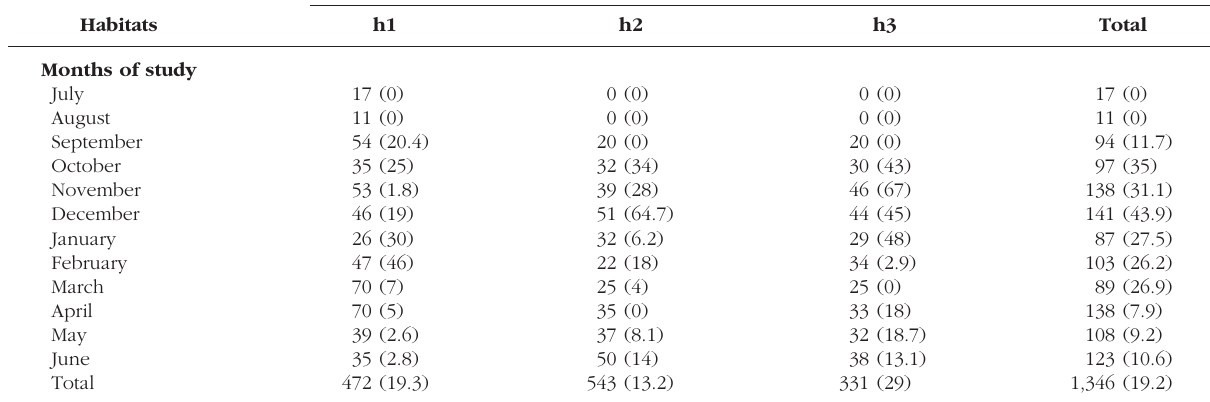
Table I. – Monthly prevalence of natural infection with F. hepatica in three populations of G. truncatula from the districts of El Gsar and Ain Soltan oases for the year